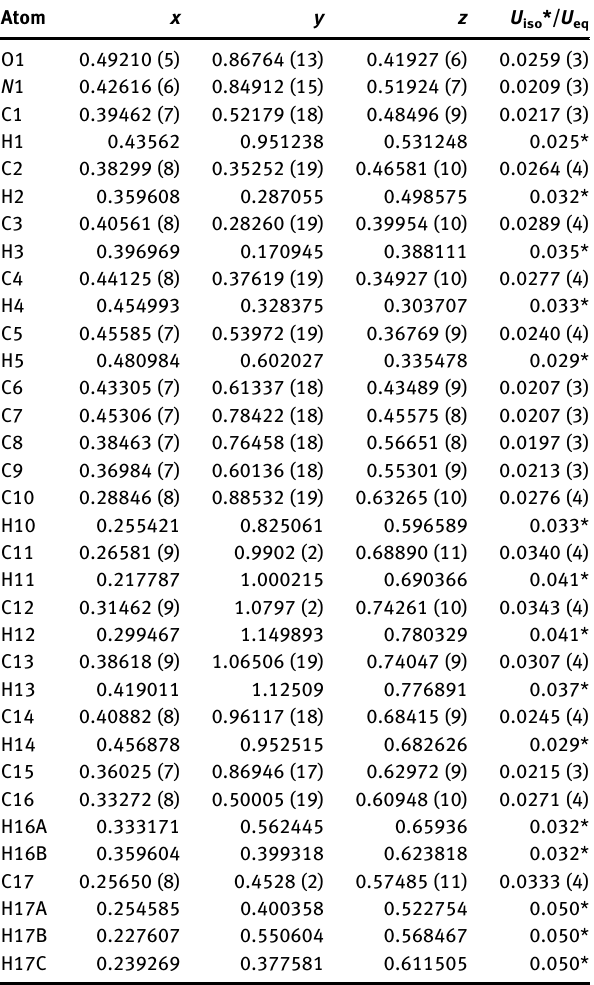
Table  : Fractional atomic coordinates and isotropic or equivalent isotropic displacement parameters (Å 